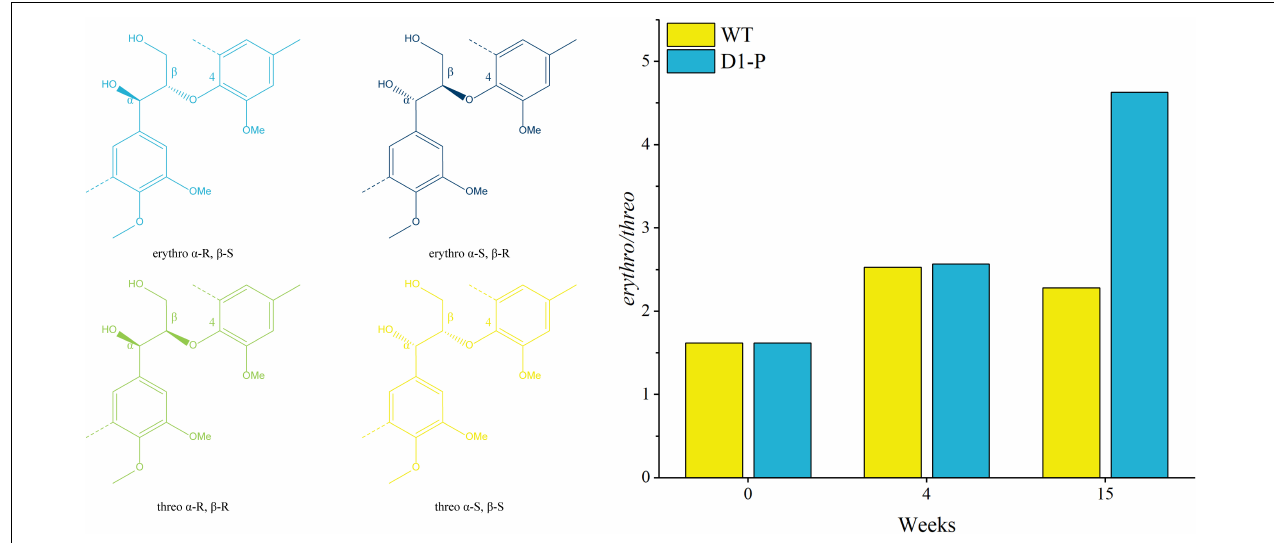
FIGURE 6 | Ratio of β -O-4 erythro/threo after degrading by WT (yellow) and fusant D1-P (blue) determined by semi-quantitative HSQC NMR spectroscopy.